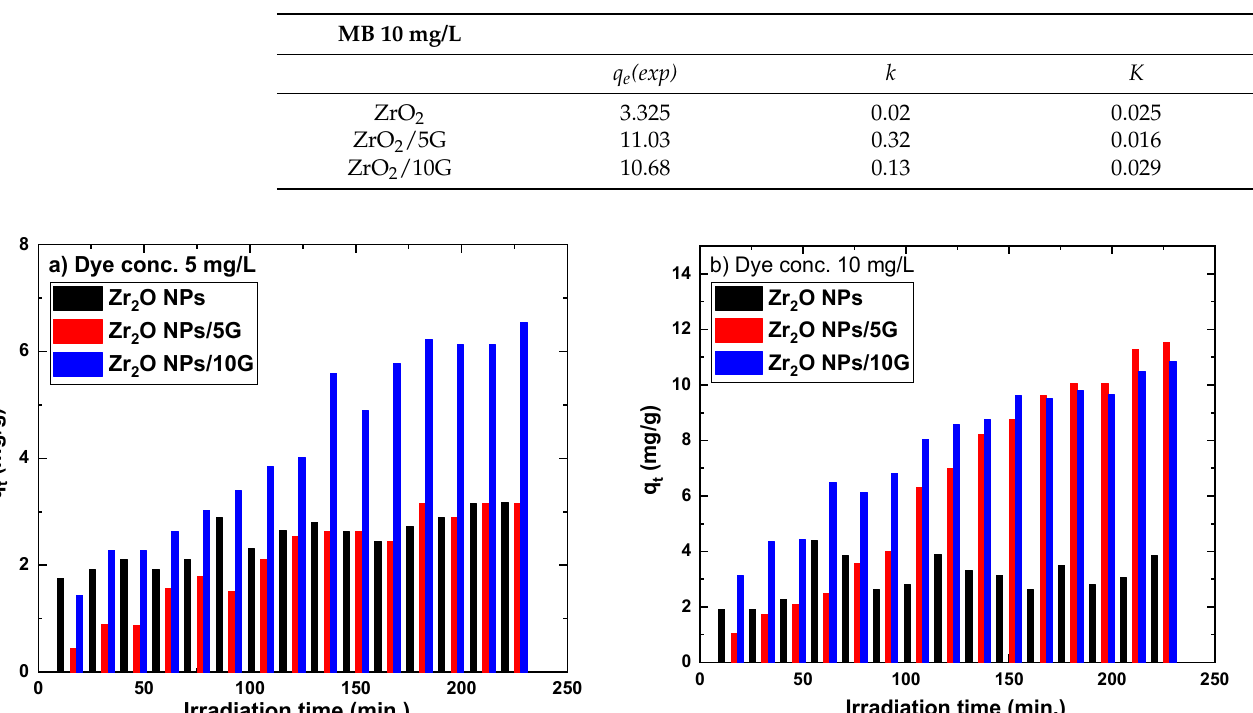
Table 4. First-order reaction rate constants ( k ) and the degradation equilibrium constant ( K ), and experimental q e values for the 10 mg/L MB degradation on ZrO 2 , ZrO 2 /5G, and ZrO 2 /10G at 303 K. MB 10 mg/L q e (exp)